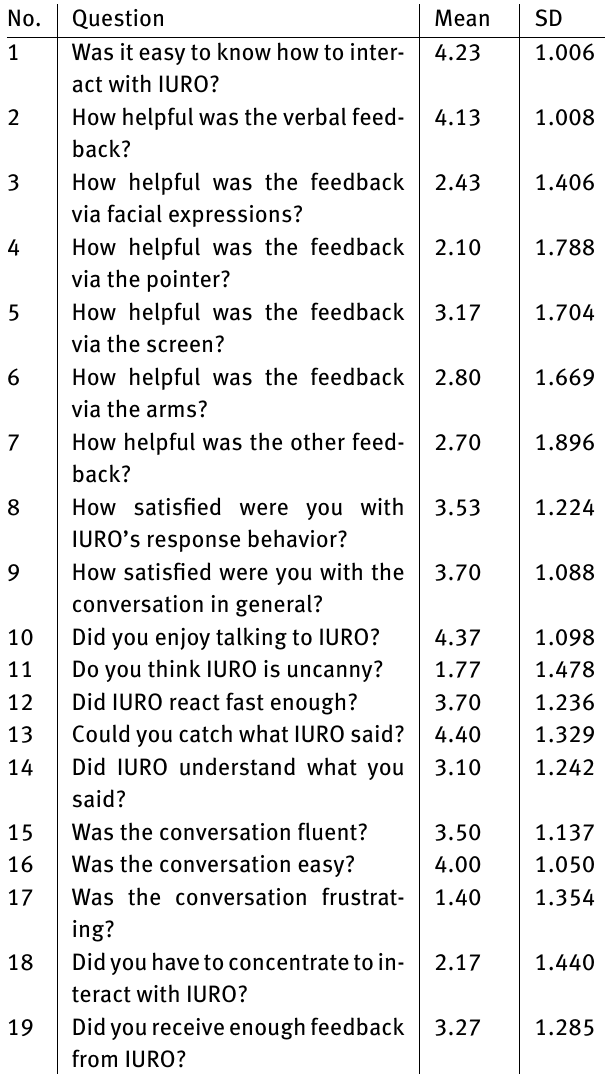
Table 7: Participants’ rating of IURO and the conversation with the robot (n=30) No.